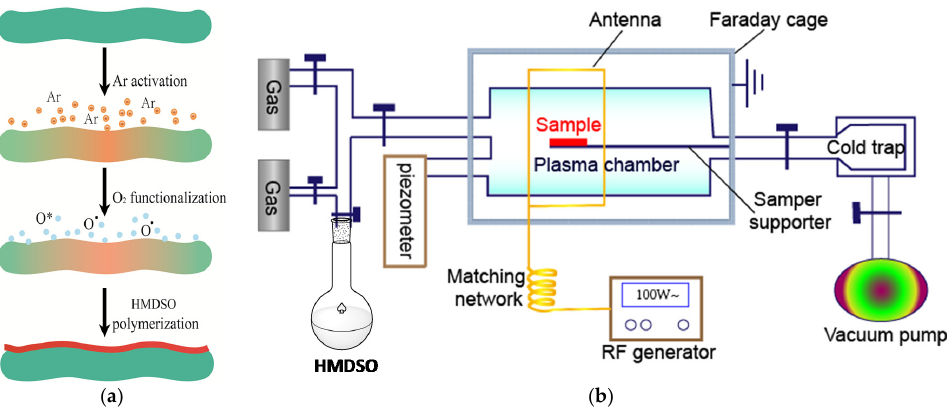
Figure 2. Schematic of ( a ) the three ‐ step plasma treatment and ( b ) the plasma device.